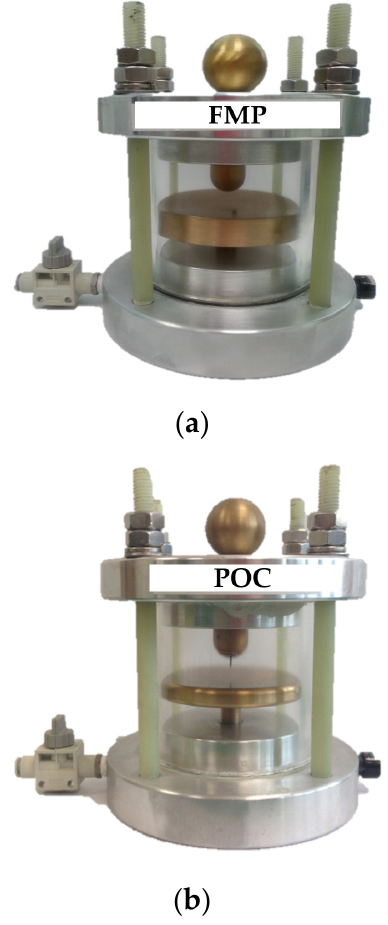
Figure 2. PD electrode systems: ( a ) FMP and ( b ) POC.